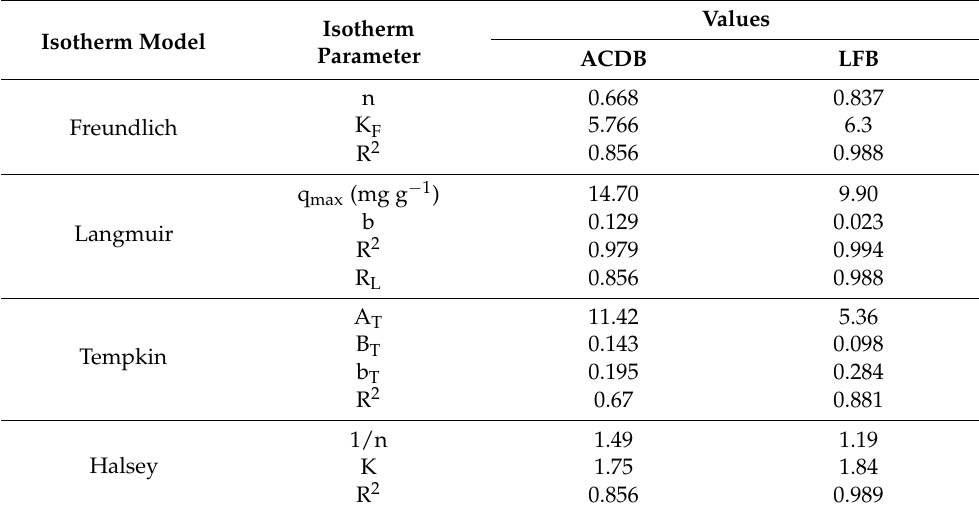
when 1/n is further than 1, cooperative adsorption takes place, and the sorption process is dye solution; when 1/n is equivalent to 1, the adsorption is linear, and the dye particle the values of factor “1/n” are less than 1 for ACDB and LFB adsorbents; the values show a physical adsorption method on an external surface with this equation to be favorable.